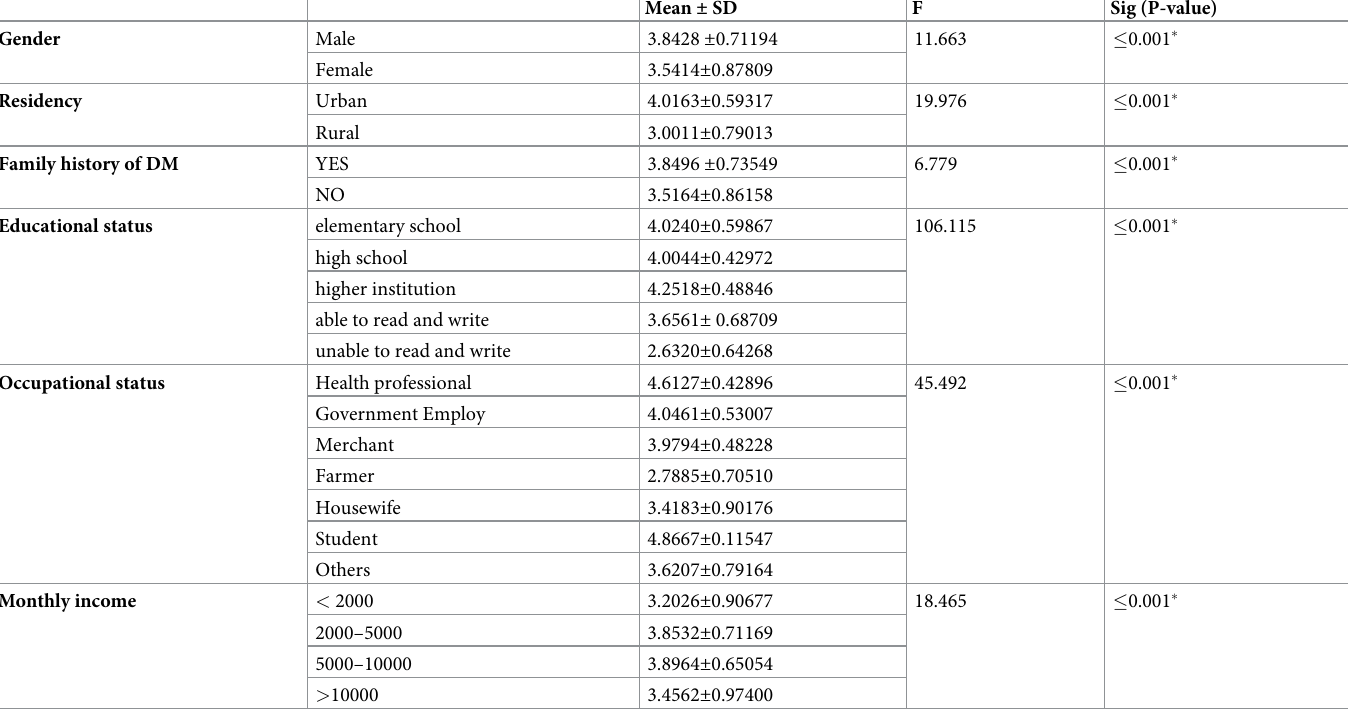
Table 3. Independent samples t-test and one-way ANOVA for mean diabetic health literacy score of the diabetic patients at the outpatient clinic of UOGCSH, 2019 (N = 400).